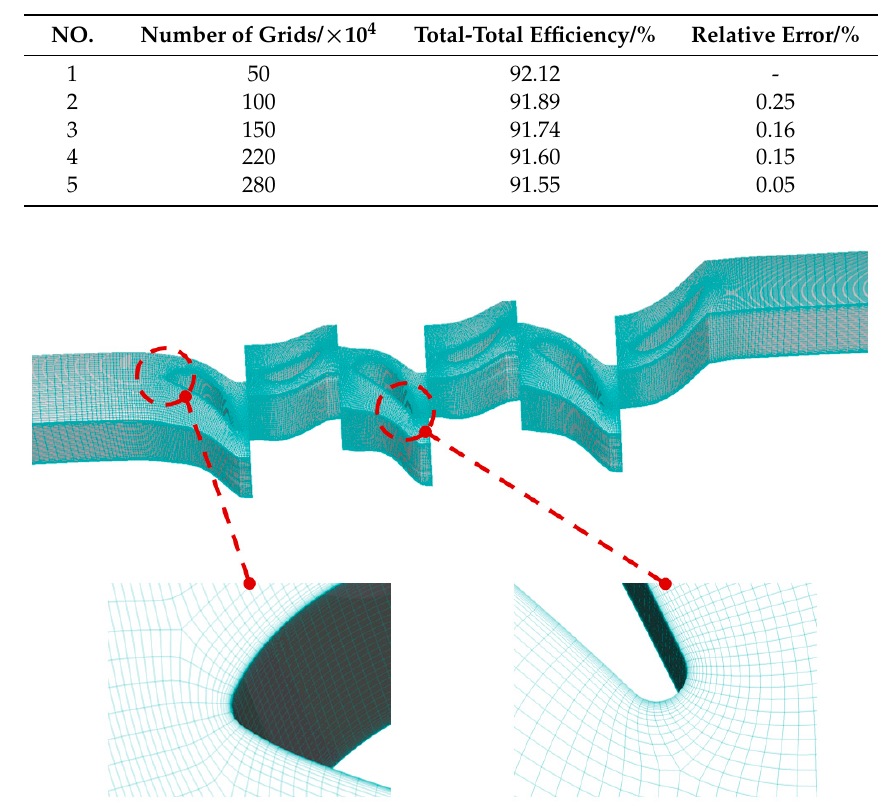
Table 4. Independence verification.